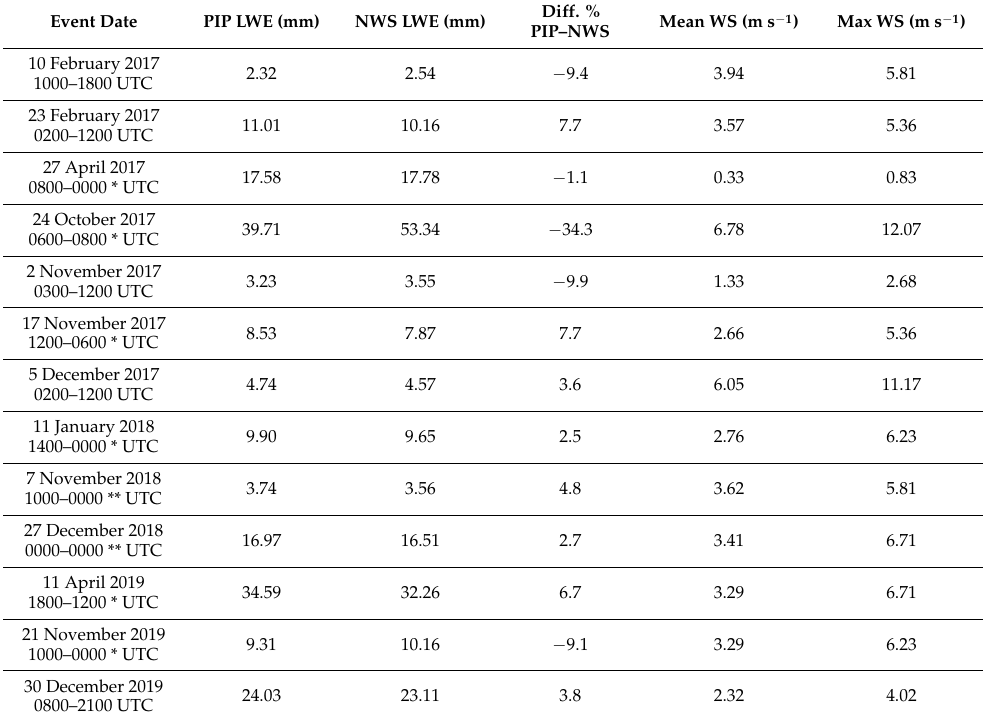
Table 3. Accumulations in LWE from the PIP and NWS observations and percentage difference for all the precipitation transition events. Differences are calculated by subtracting the NWS from the PIP accumulation and then dividing by the PIP accumulation. Mean and maximum wind speeds during the events are included. * Denotes +1 day and ** denotes +2 UTC from start